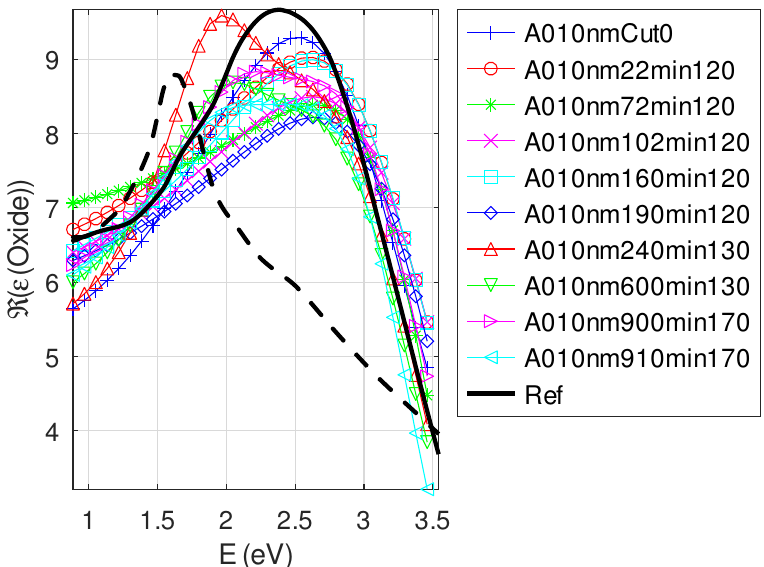
Figure A4. Real part of the relative permittivity of oxide as a function of the photon energy: bulk Cu 2 O (black solid line), bulk CuO (black dashed line) and best calculated (color) for each oxidized = 10 nm). sample (initial thickness h 0 Cu